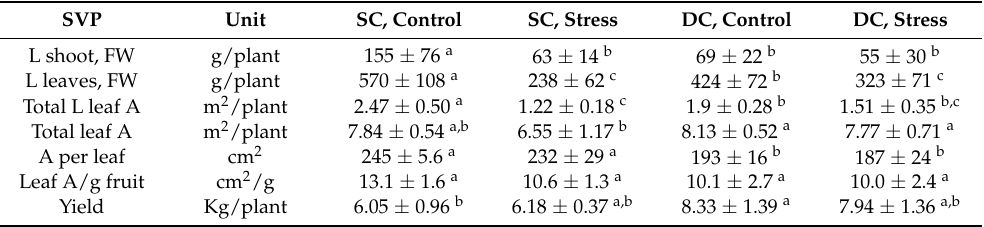
Table 4. Overview of secondary vegetative parameters (SVP) and total plant values including yield, as measured in the water deficit (WD) groups. Values represent group averages ( ± STD). Different letters (a, b, c) indicate significant differences between groups. Keys: L = lateral, FW = fresh weight, A = area, SC = single cane, DC = double